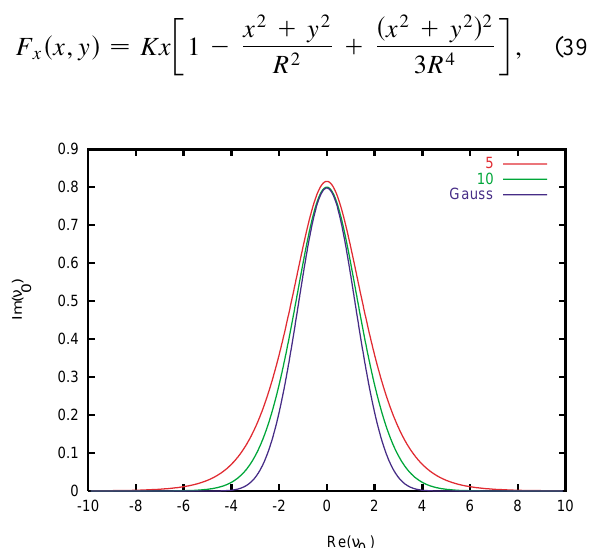
FIG. 4. (Color) Threshold diagrams for the distributions shown in Fig 3.